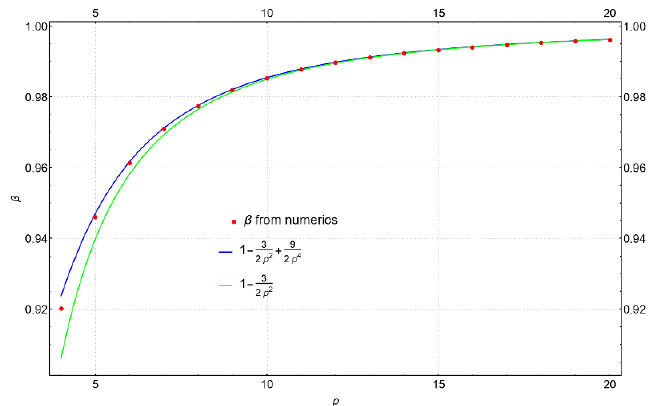
Figure 8 . The circumference (cid:12) ( (cid:26) ) for large (cid:26) , in units of (cid:12) H